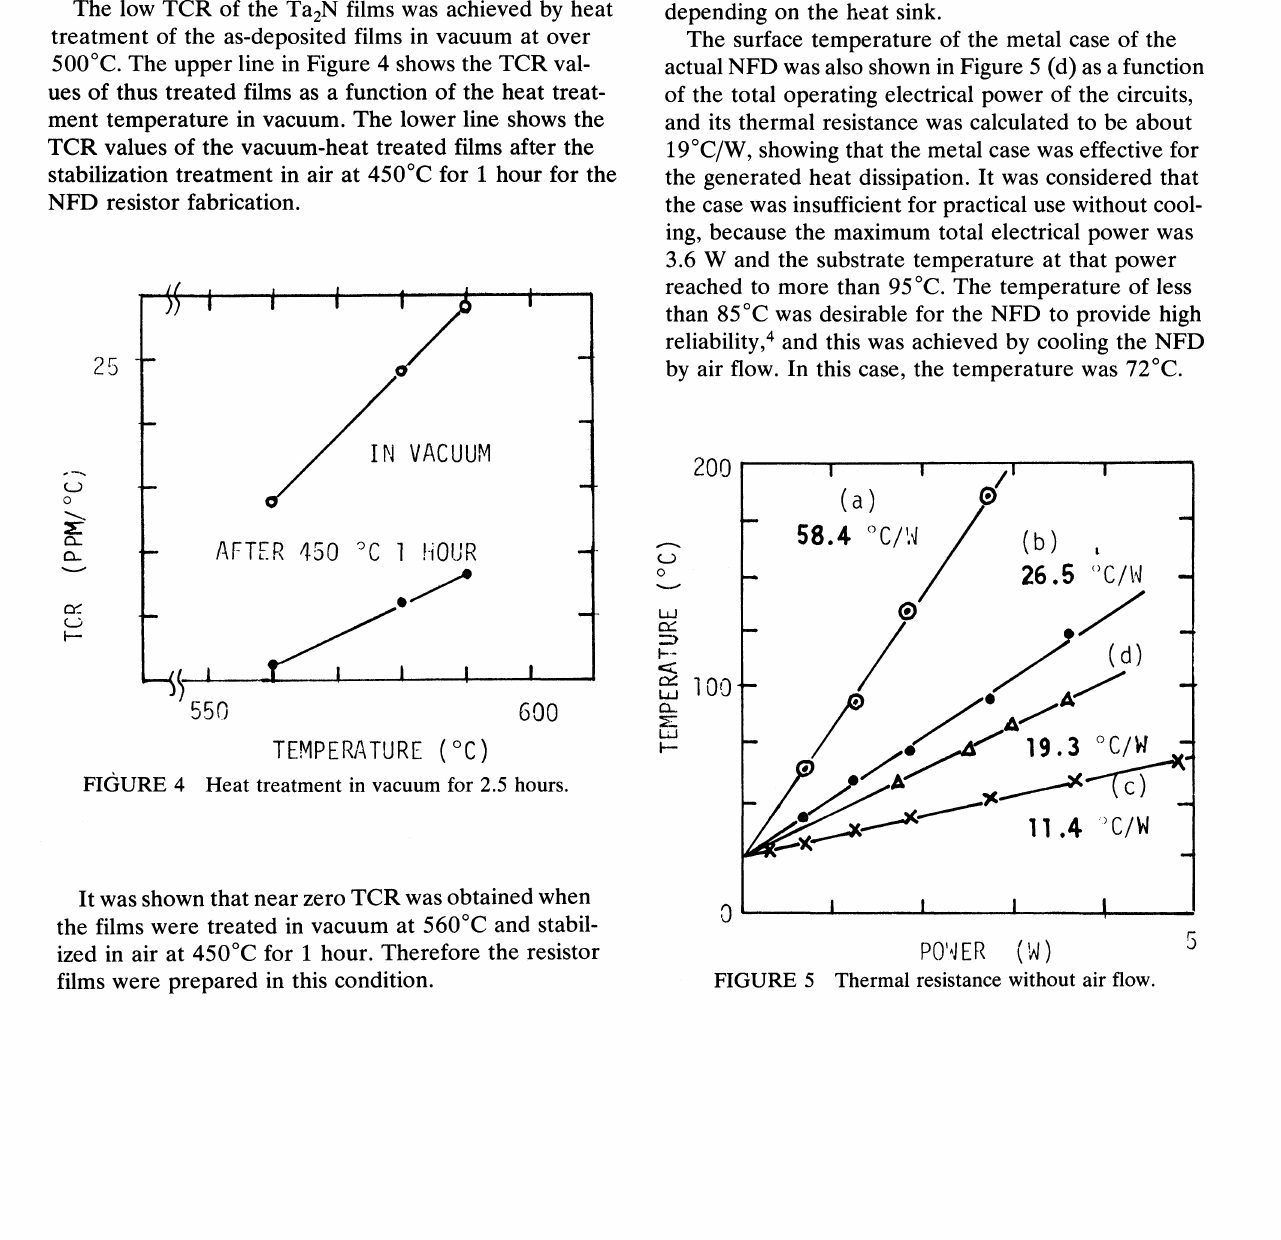
FIGURE 5 Thermal resistance without air